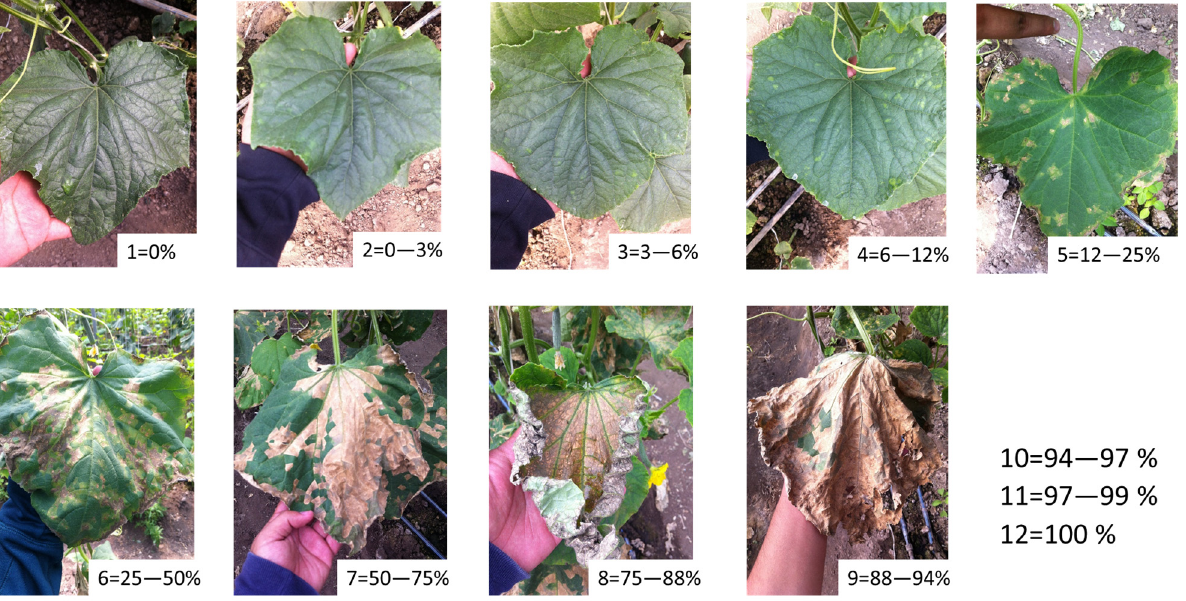
Figure 1. Horsfall–Barratt method for the establishment of severity index of downy mildew in cucumber leaves. Percentage represents the fraction of damage in the